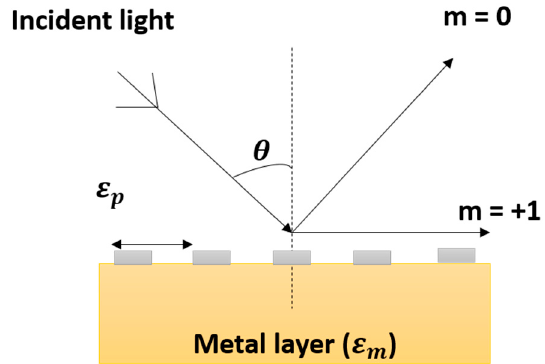
Figure 5. Excitation of surface plasmons by the diffraction grating method [45].